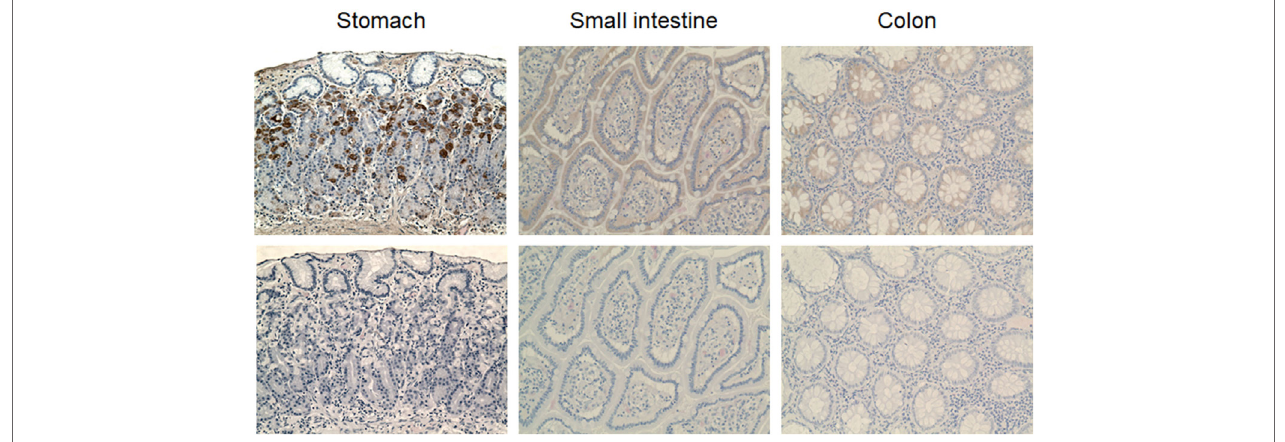
FigUre 8 | VPAC1 immunohistochemical staining in the normal human gastrointestinal tract. Sections of human stomach (left panels), small intestine (middle panels), and colon (right panels) were dewaxed, microwaved in citrate buffer, and incubated with 300 nM CA7281 (top panels). Bound nanobodies were detected using the peroxidase-antiperoxidase (PAP) method and sections were counterstained with hematoxylin and eosine. Bottom panels show the results obtained on adjacent sections treated similarly, but omitting the nanobody. Pictures were taken on a Zeiss Axioplan two microscope (original magnification 20 ×